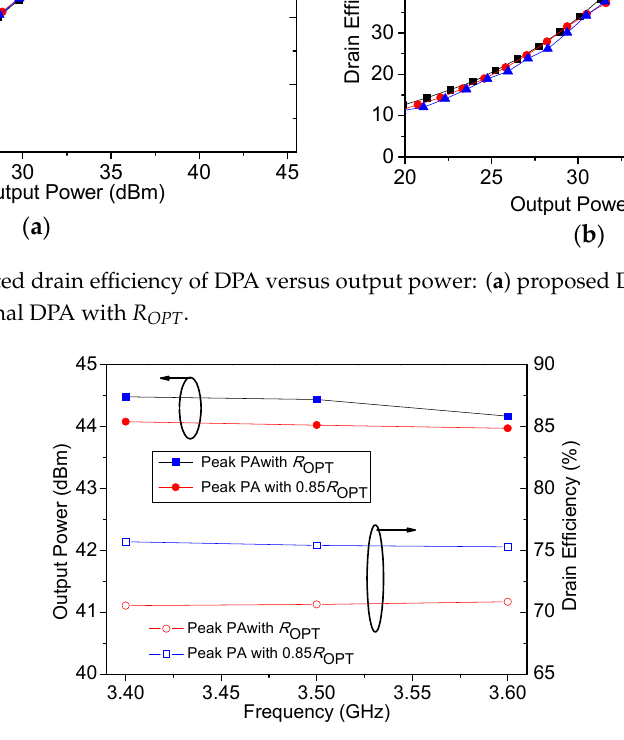
Figure 12. Simulated drain efficiency and output power of DPA in saturation.